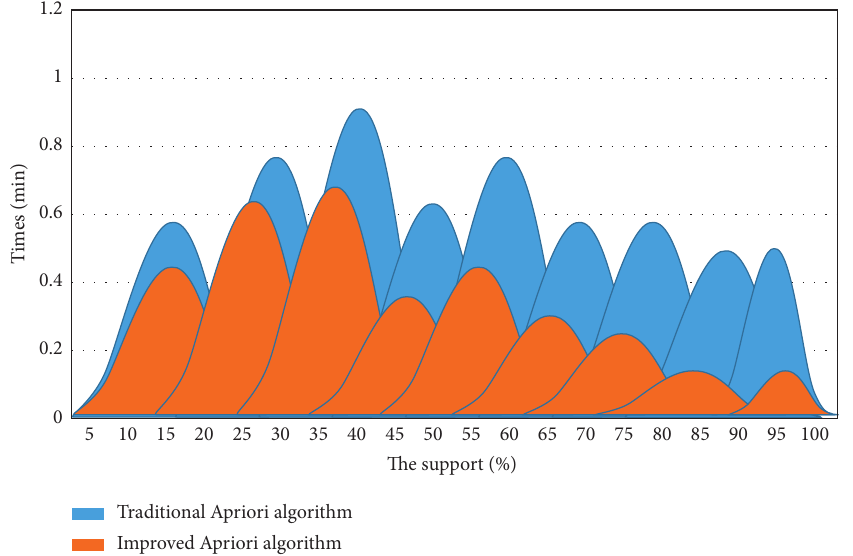
Figure 6: Experimental comparative analysis results of different support settings for the same transaction